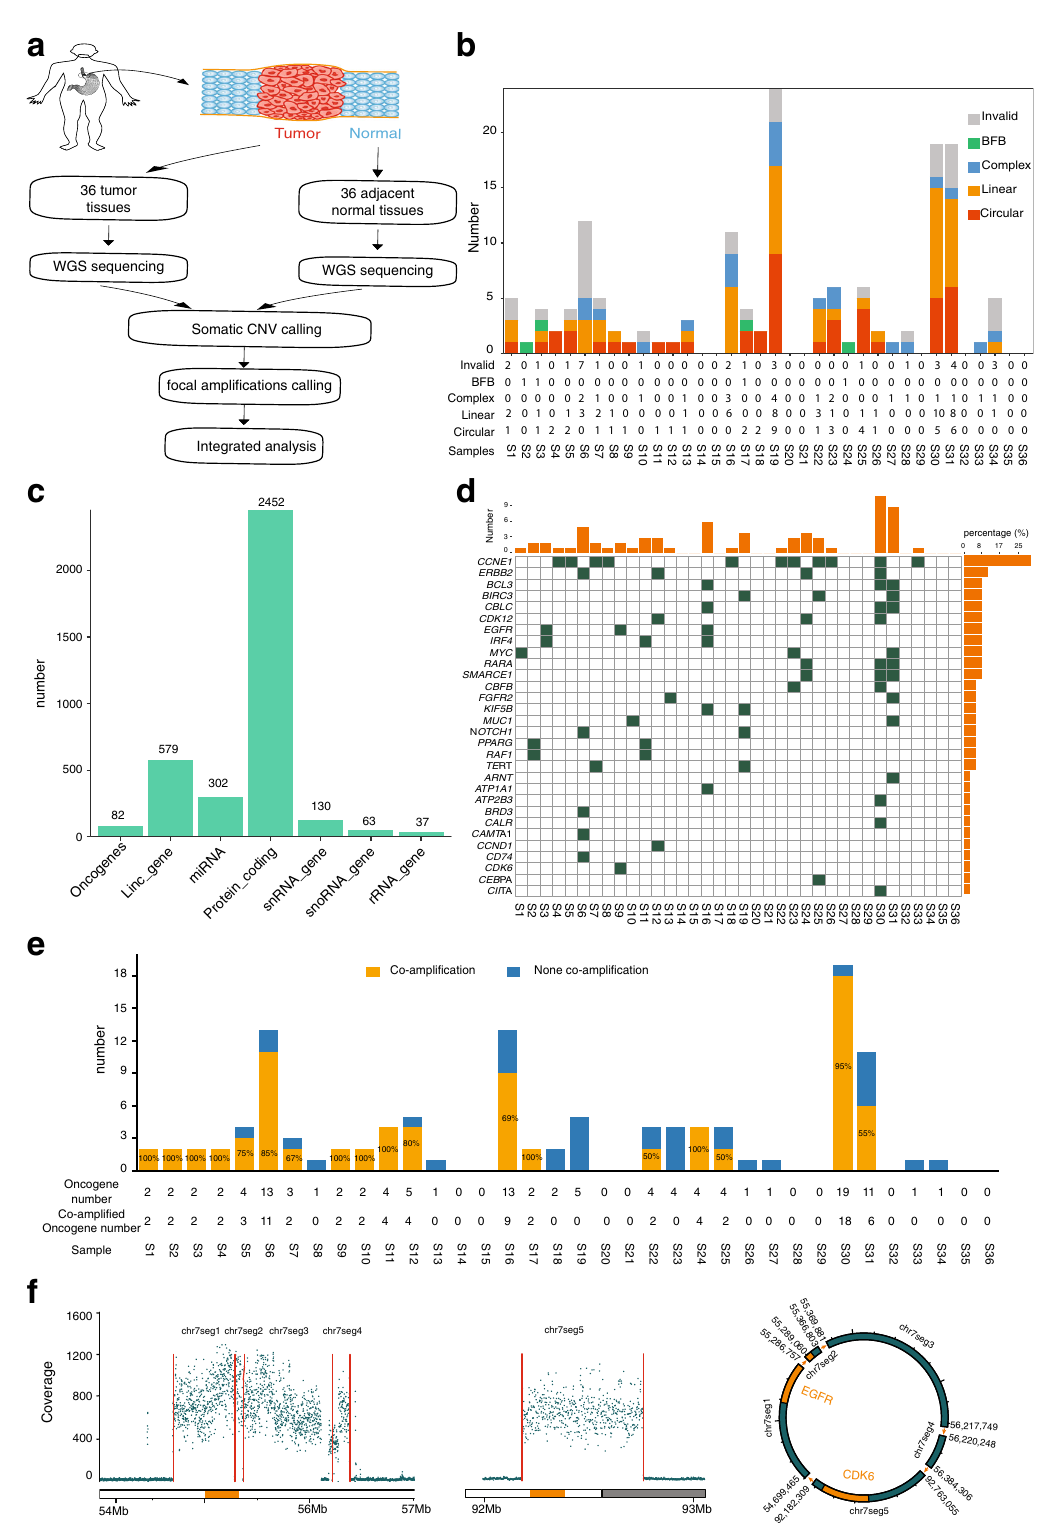
genome, including 2452 sites in protein coding regions and 579 sites in long intergenic non-protein coding RNA (lincRNA) (Fig. 1c). However, the frequency of focal ampli fi cations observed in coding regions (6.28%) was higher than the proportion of coding regions in the whole genome (3.48%) (Supplementary Fig. 2f). Furthermore, the proportion of focal ampli fi cations detected in the exons (14.5%) is higher than that of exons in the